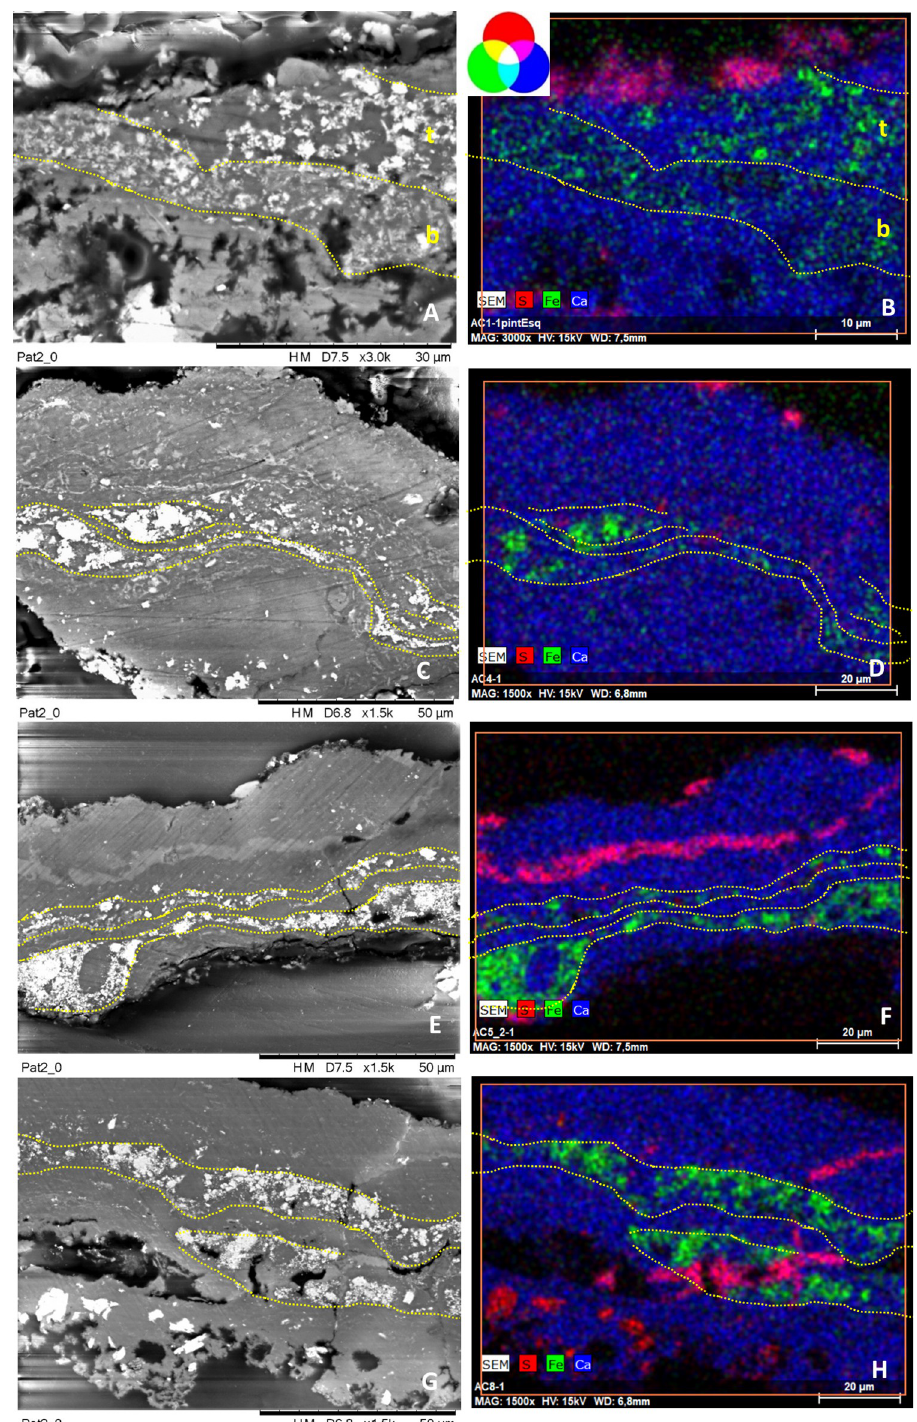
Fig 8. SEM backscattered images and their RGB composite images of the elemental distribution of S K α /Fe K α /Ca K α of a selected area of the cross-sections AC1 (images A-B), AC4 (images C-D), AC5.2 (images E-F), AC8 (images G-H) constitutive of group 2. See S1 Figs 6–8 in S1 File Figs to visualize the location of the analyzed areas (framed by red squares).